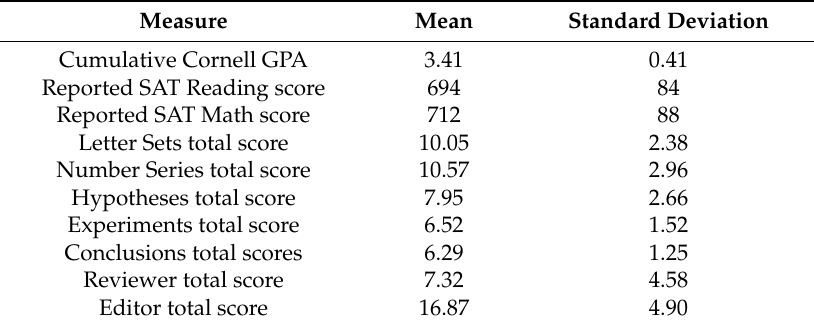
Table 9. Mean scores and standard deviations in Study